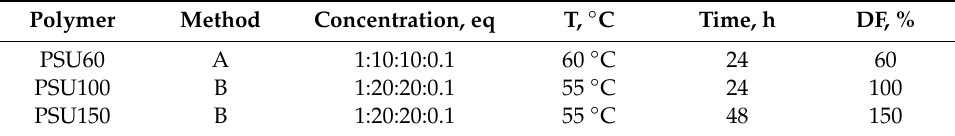
Table 1. Degree of functionalization (DF) of chloromethylation PSU.